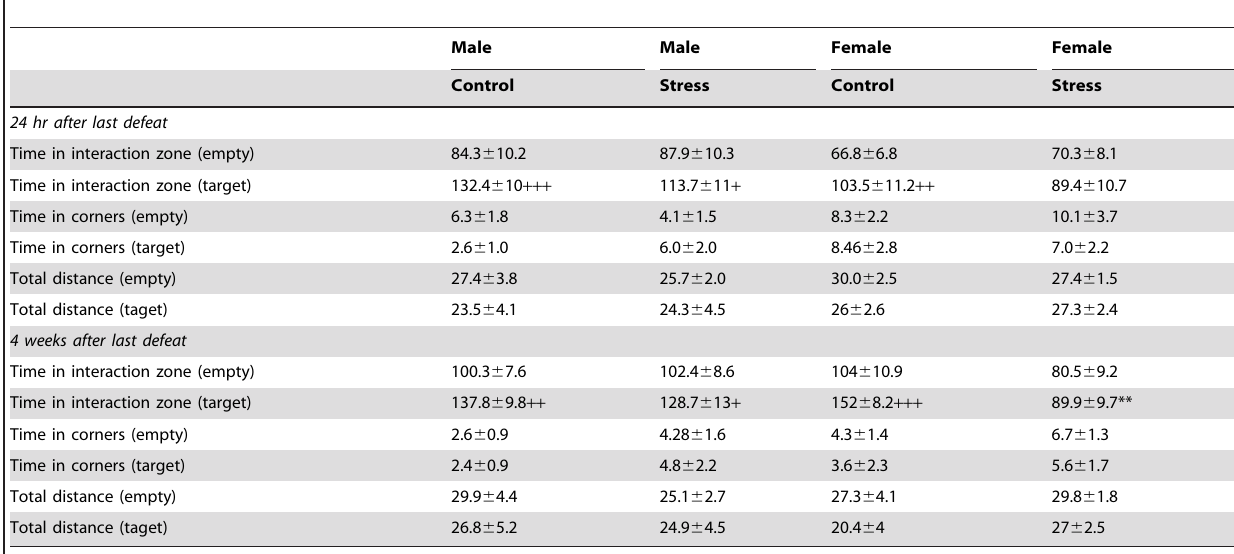
Table 1. Behavioral data from social interaction tests with empty cage and a novel mouse (target).